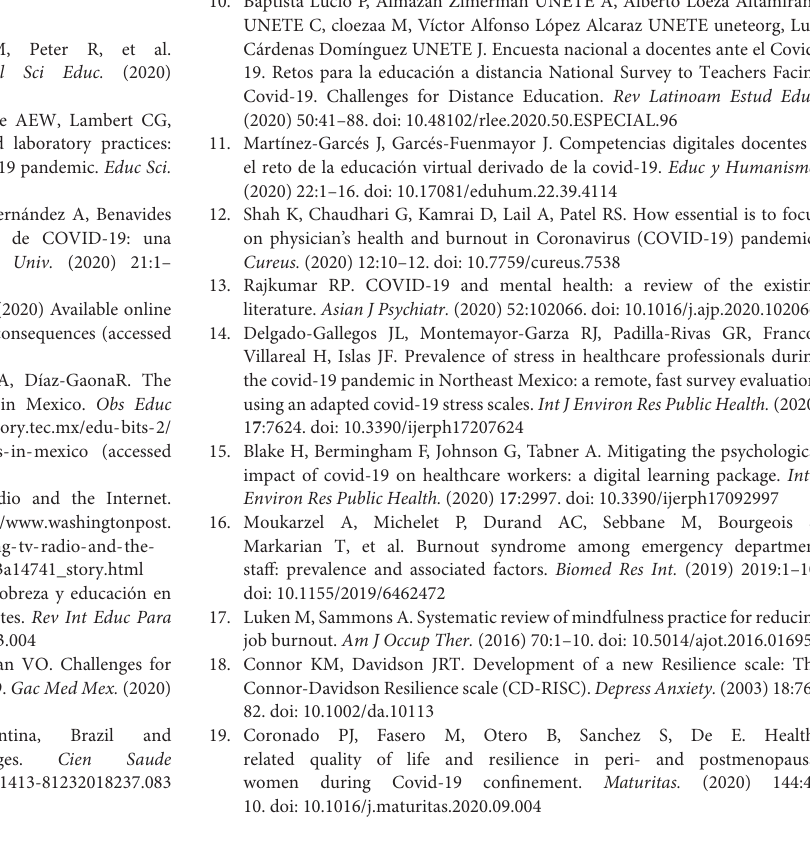
Supplementary Table 2 | Statistical Correlations for Age (by groups) vs. Adapted COVID STRESS SCALES, Resilience, Teaching Anxiety and Preparedness, and FOBAP.